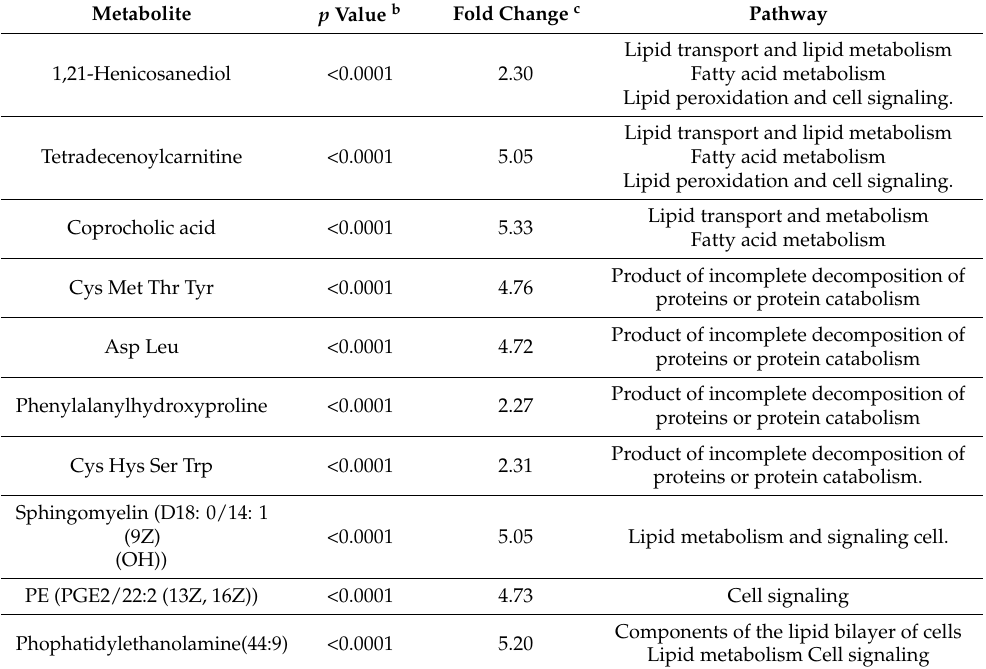
Table 5. Urinary metabolomic biomarkers related to oxidative stress and benzene-induced chromoso- mal